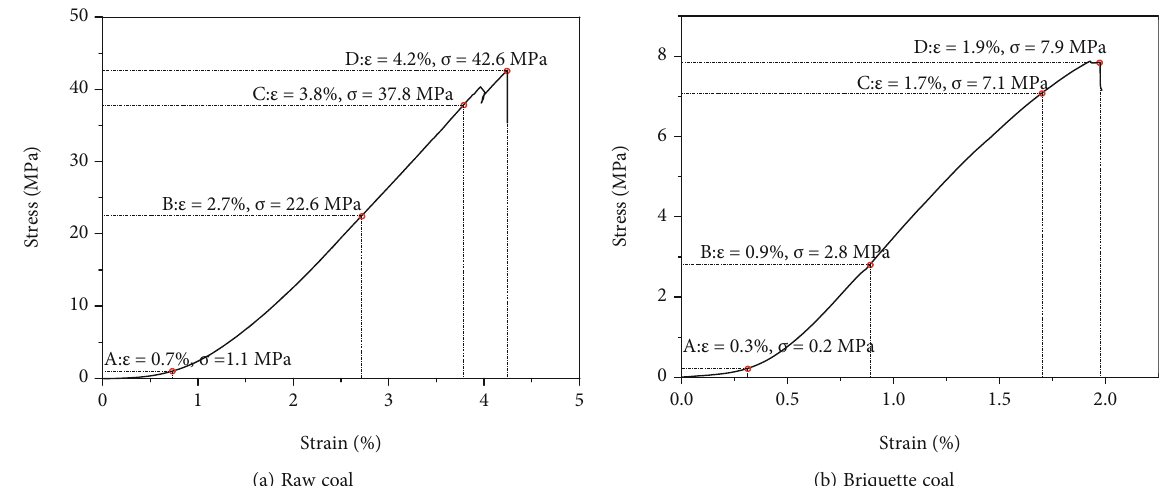
Figure 5: Stress-strain curves and observation times of